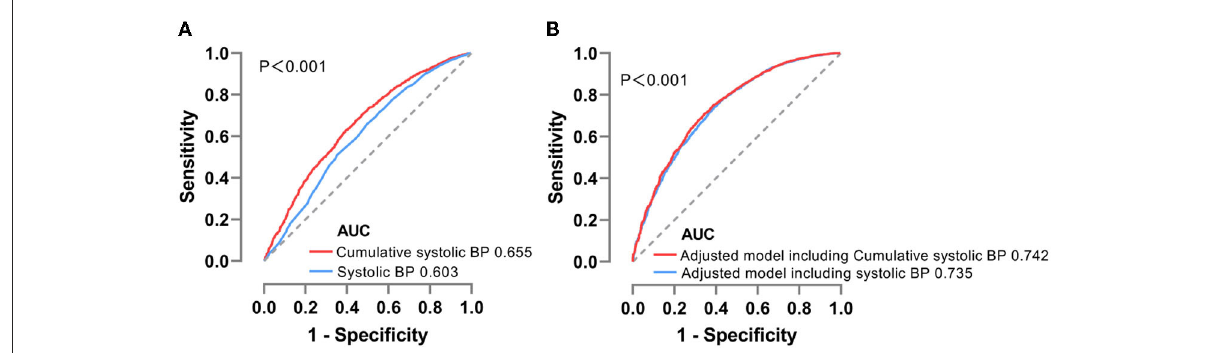
FIGURE3 (A) ROC analysis for baseline or cumulative systolic BP distinguishing CVD incidence. (B) ROC analysis for the inclusion of baseline or cumulative systolic BP to adjusted models predicting CVD incidence. ROC, receiver operating characteristic; AUC, area under curve; CVD, cardiovascular disease; BP, blood